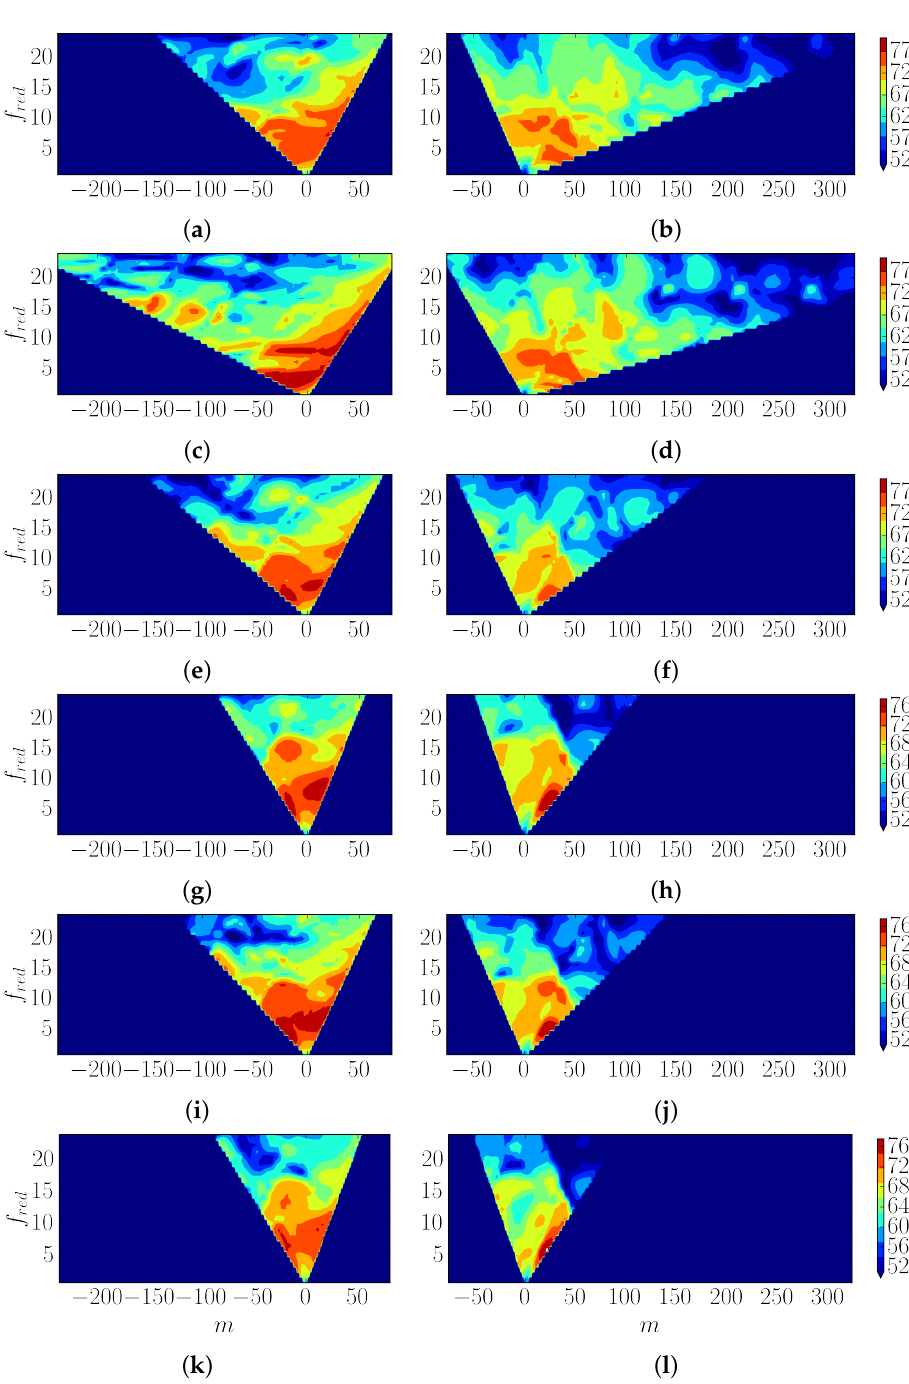
Figure 14. NSPL modal decomposition at all the OP considered. Left column: inlet. Right column: outlet. ( a , b ): OP1; ( c , d ): OP2; ( e , f ): OP3; ( g , h ): OP4; ( i , j ): OP5; ( k , l ): OP6.The scale is saturated below the lower limit for enhanced